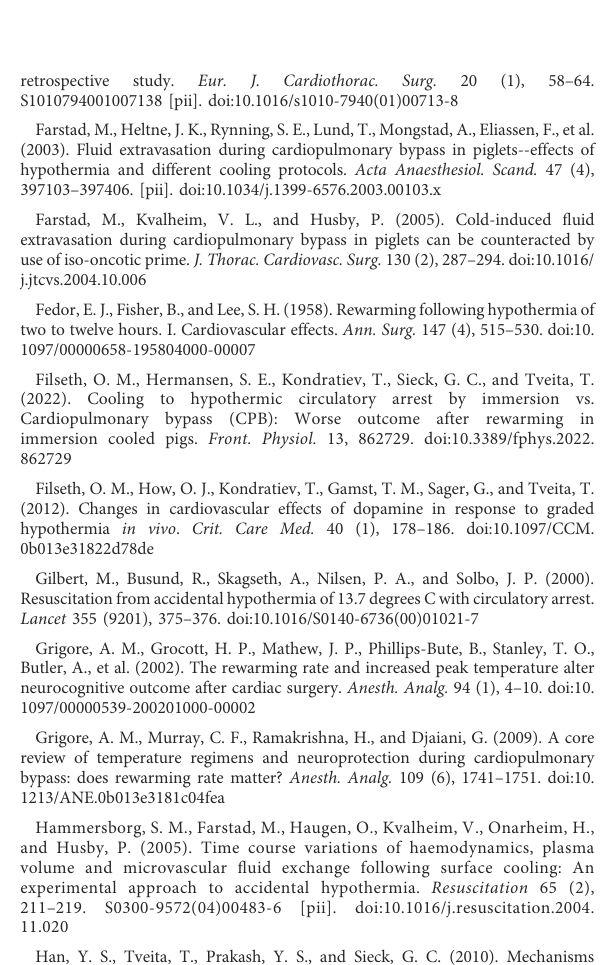
SUPPLEMENTARY FIGURE S1 Intraoperative image of the heart